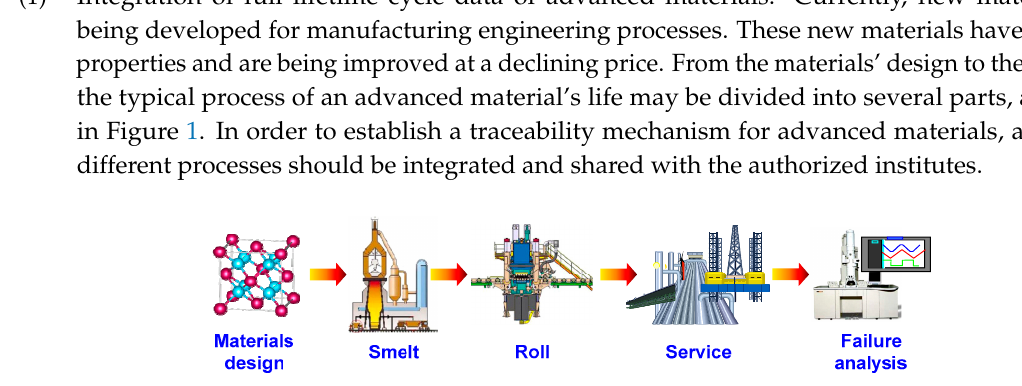
Figure 1. Typical process diagram of an advanced material’s life.